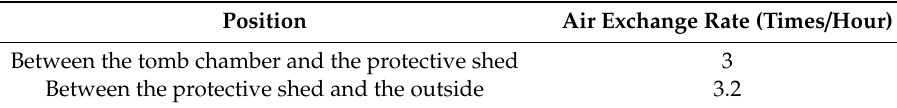
Table 1. Air exchange rates.